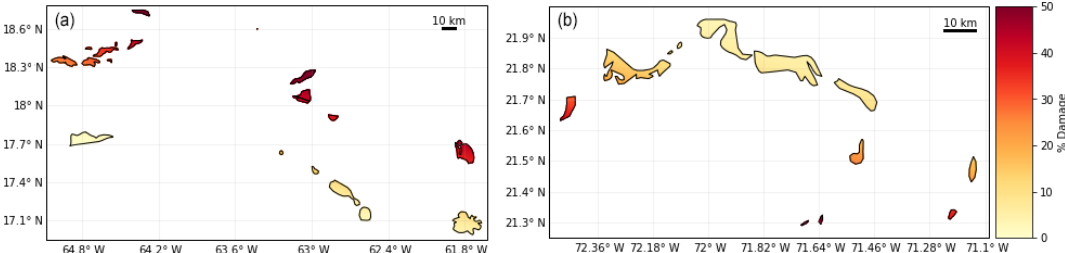
Figure 4. Economic damage computed by CLIMADA as percentage of local exposure (per pixel). (a) Lesser Antilles; (b) Turks and Caicos